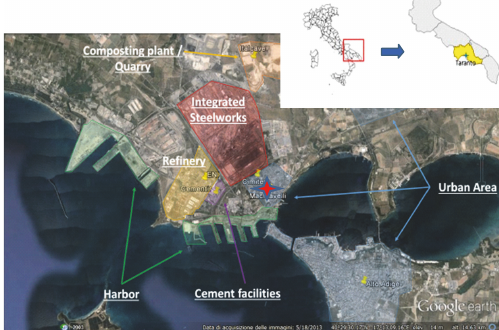
Figure 1: Map of Taranto (south of Italy). Red star shows sampling